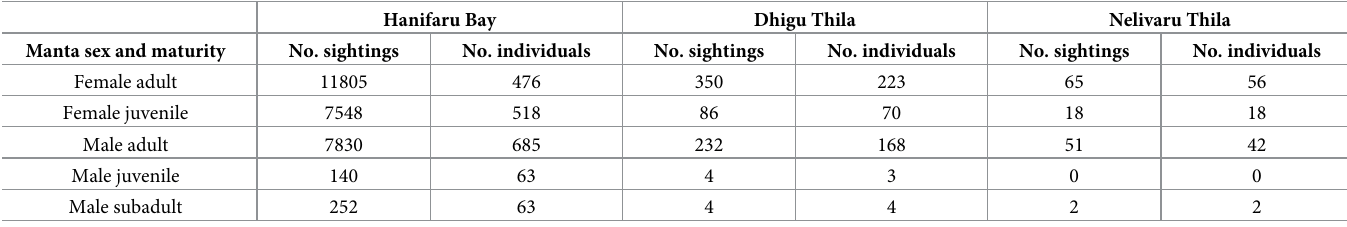
Table 3. Summary of all photo identification records from key habitats by demographics. Hanifaru Bay Dhigu Thila Nelivaru Thila Manta sex and maturity No. sightings No. individuals No. sightings No. individuals No. sightings No. individuals Female adult 11805 476 350 223 56 7548 7830 685 232 168 51 42 140 63 4 3 0 0 Male subadult 252 63 4 4 2 2 Total sightings of M . alfredi and number of individuals identified at the key habitats by demographic